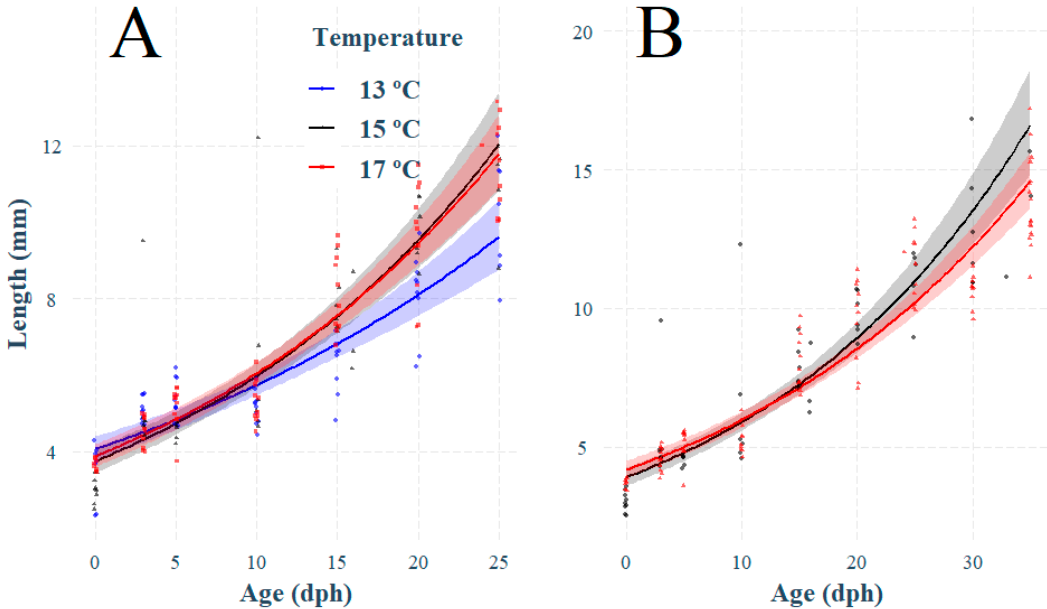
Figure 1. Total length (TL, mm) vs. age (days post ‐ hatching, dph) of European sardine Sardina pilchardus (Walbaum, 1792) larvae reared under three different temperatures (13, 15, 17 ° C) from 0 to 25 dph ( A ) and from 0 to 35 dph ( B ). Results of the GLMs are presented in Table 1. Table 1. Results of the generalized linear models (GLMs) of (a) total length (TL, mm) vs. age (days post ‐ hatching, dph) and temperature (Temp), (Gamma, log ‐ link); (b) number of growth increments (GI) vs. age or length and temperature (Poisson); otolith diameter (Diam, μ m) vs. age or length and temperature, (Gamma, log ‐ link) of European sardine Sardina pilchardus (Walbaum, 1792) larvae reared at three different temperatures (13, 15, 17 ° C). Two time periods were tested, from hatch to 25 dph to compare the three temperatures and from hatch to 35 dph for treatments 15 and 17 ° C since no larvae survived in the 13 °C treatment after 25 dph.